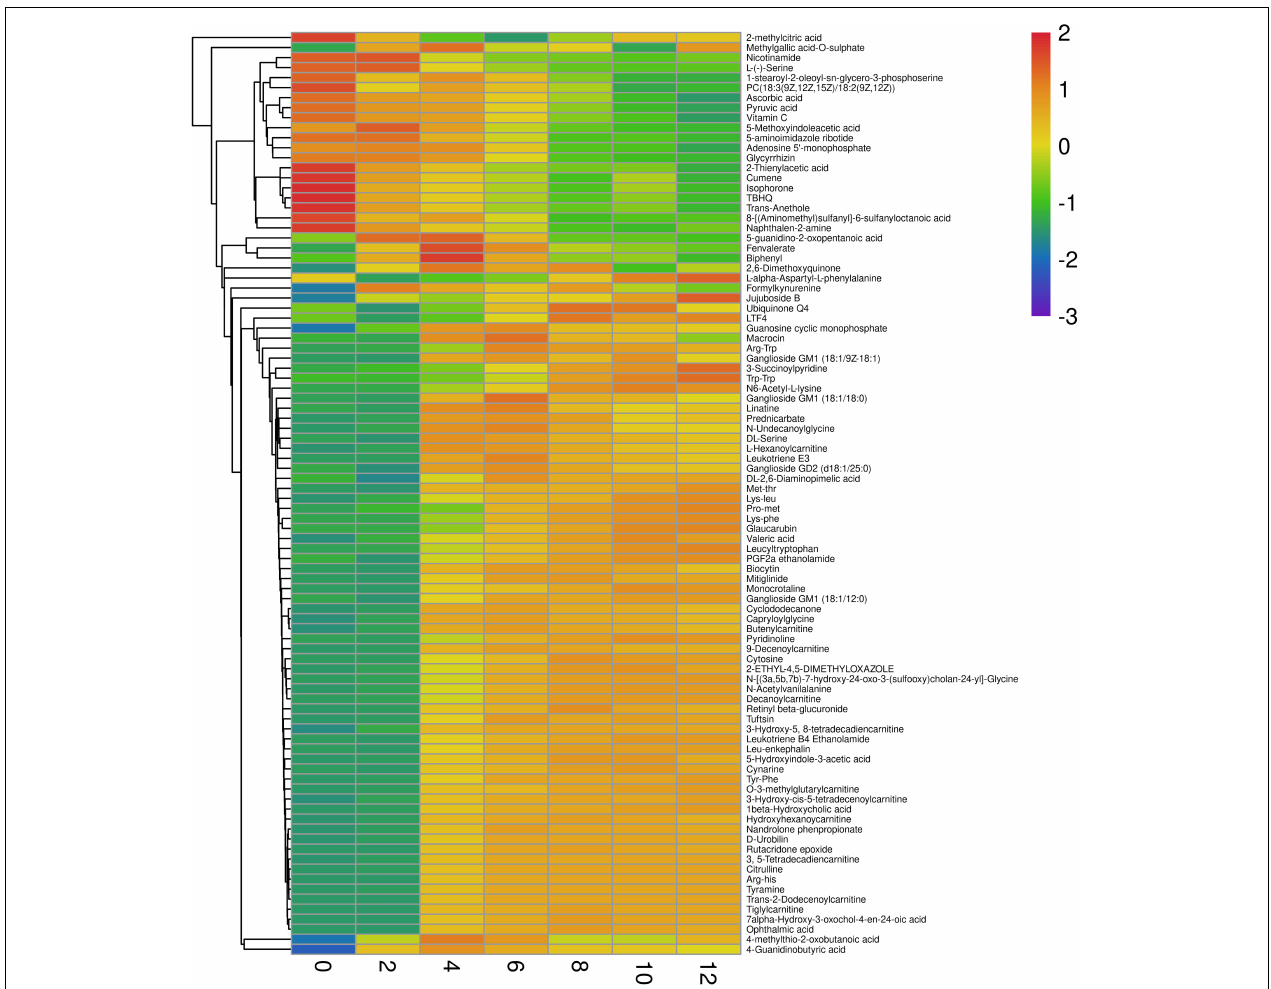
FIGURE 5 | Heatmap of individual non-volatile metabolites determined in both positive and negative ion modes. The scale with the range from –3 to 2 refers to the trend of peak area after logarithmic transformation. Red and blue color indicates the high and low content of different non-volatile metabolites, respectively.